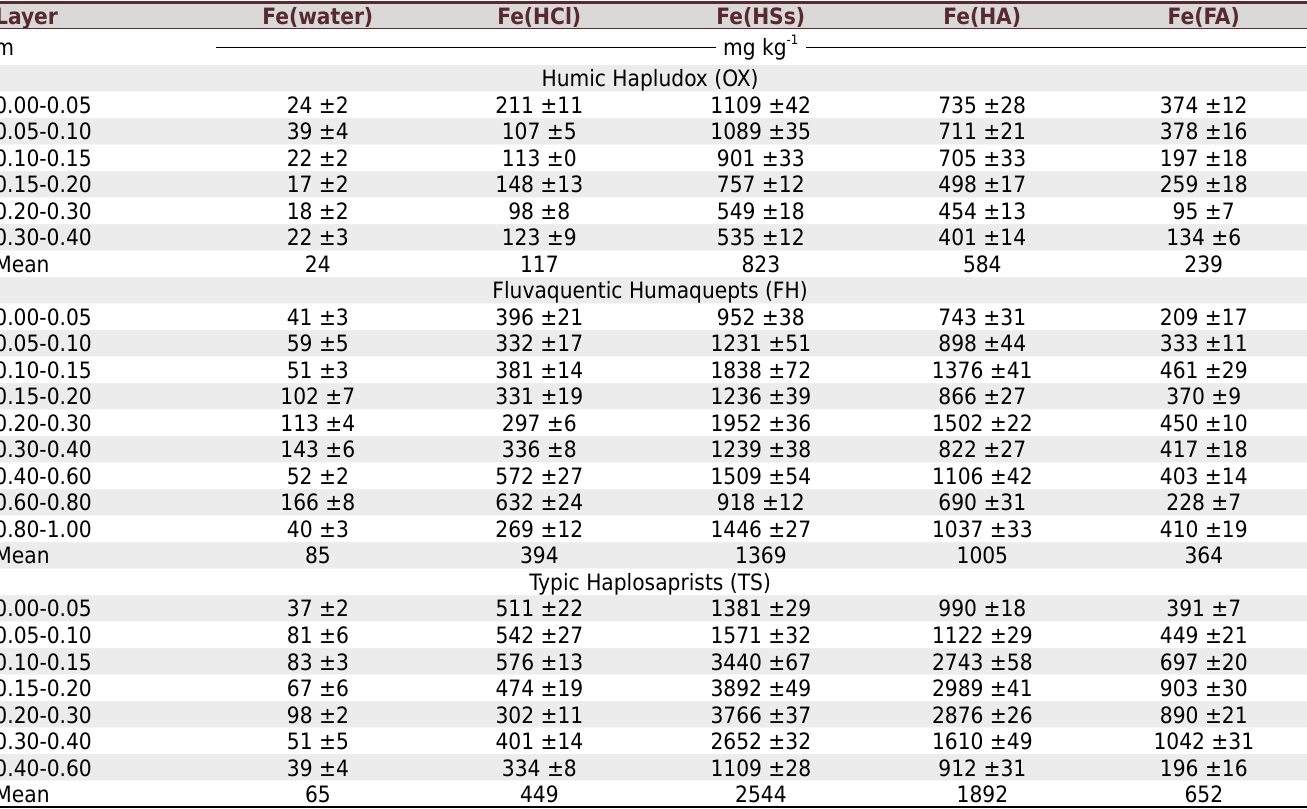
Table 4. Iron in water extract [Fe (water) ], Fe in HCl extract [Fe (HCl) ], Fe in NaOH extract [Fe (HSs) ], Fe associated with HA [Fe (HA) ], and Fe in FA extract [Fe (FA) ] contents of soils in a toposequence under Araucaria moist forest in southern Brazil